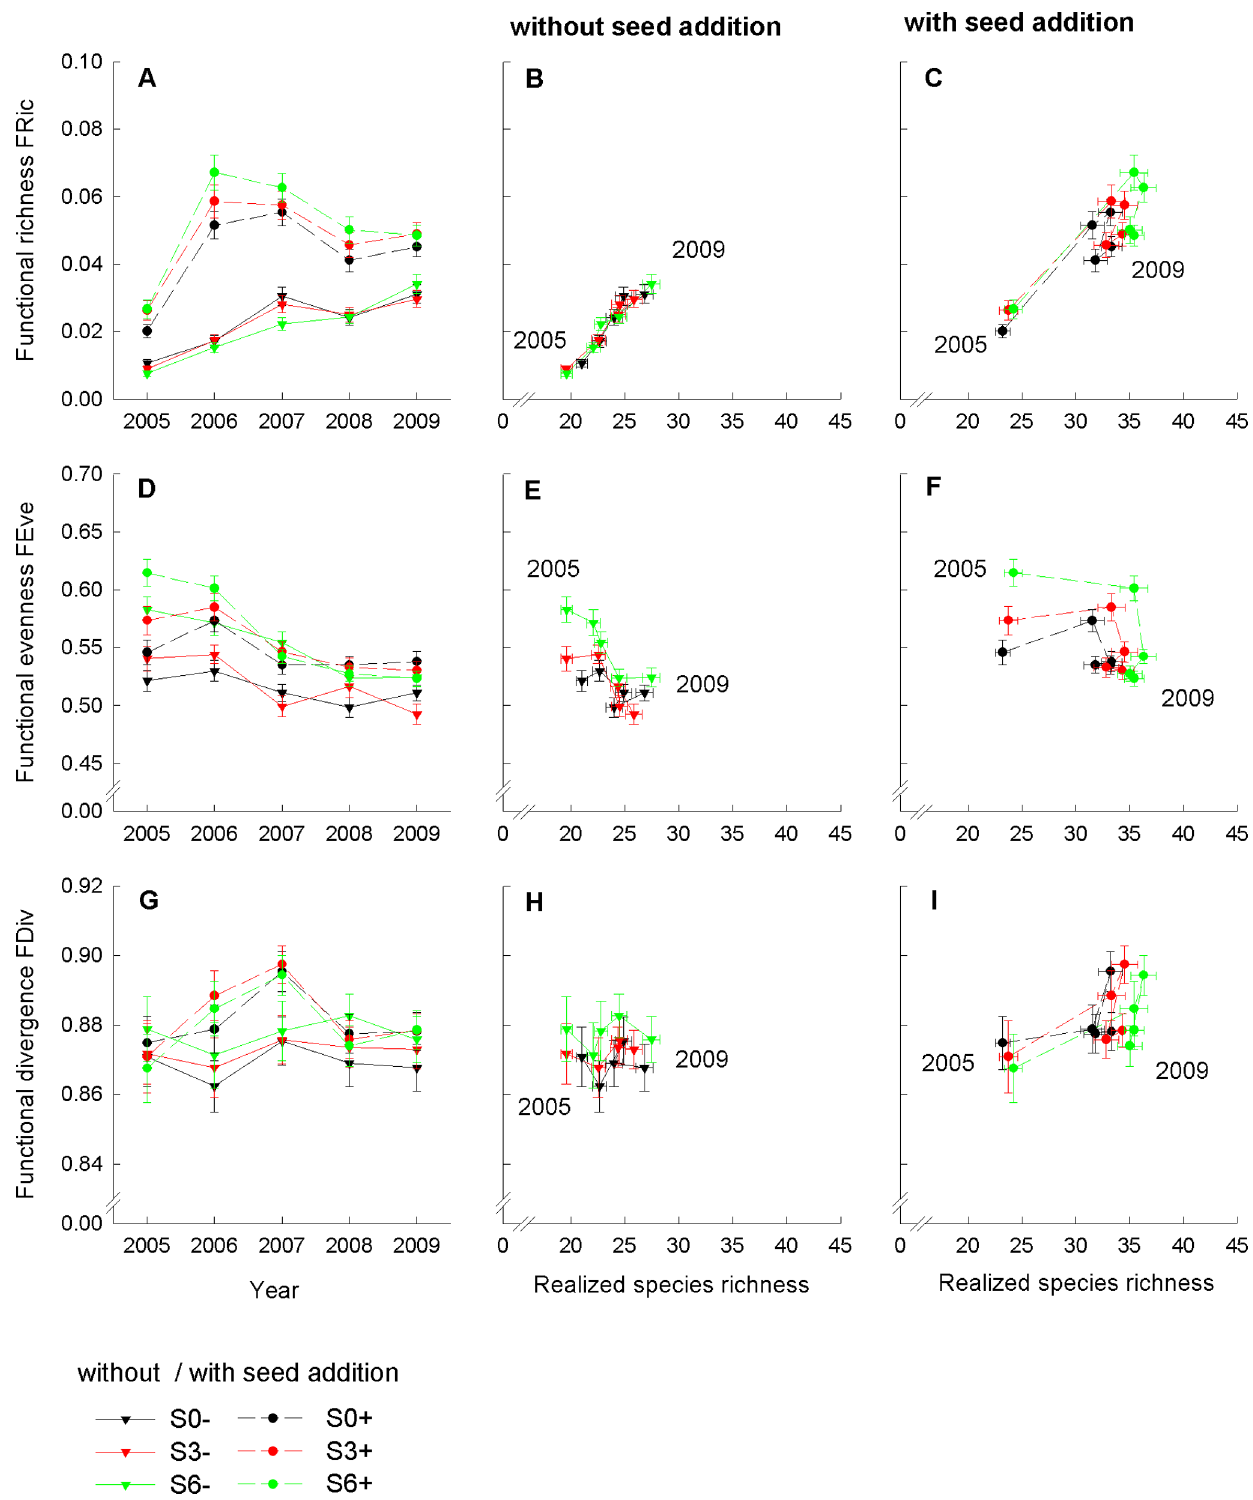
Figure 4. Functional richness (FRic), functional evenness (FEve) and functional divergence (FDiv) per colonization period. FRic as a function of time (A), and plotted against realized species richness (B, C), FEve as a function of time (D), and plotted against realized species richness (E, F), and FDiv as a function of time (G), and plotted against realized species richness (H, I) as mean values ( 6 1SE) per colonization period across initial species-richness levels. Treatments without seed addition are shown in (B, E, H), and treatments with seed addition are shown in (C, F, I).